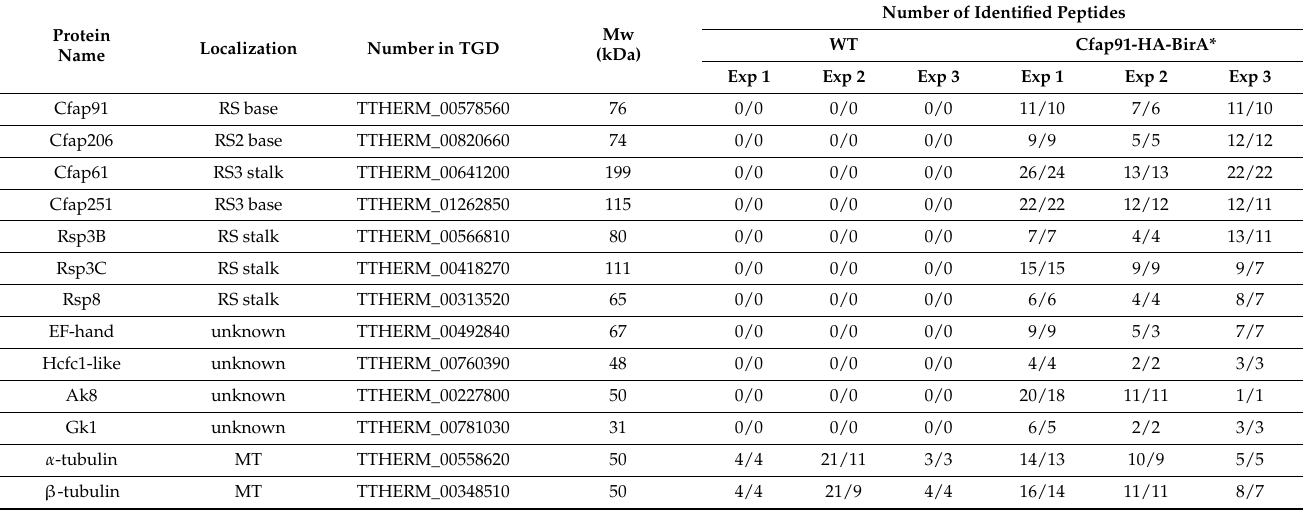
Table 1. Mass spectrometry-based identification of ciliary proteins biotinylated in cells expressing the Cfap91-HA-BirA* fusion